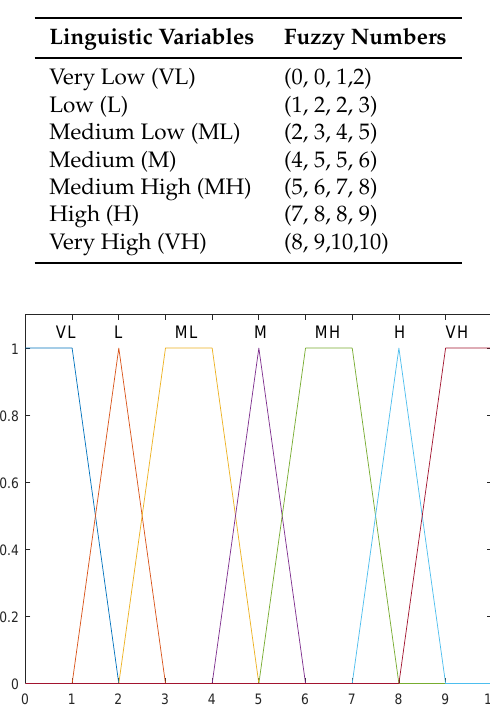
Table 4. Linguistic variables for the evaluation.